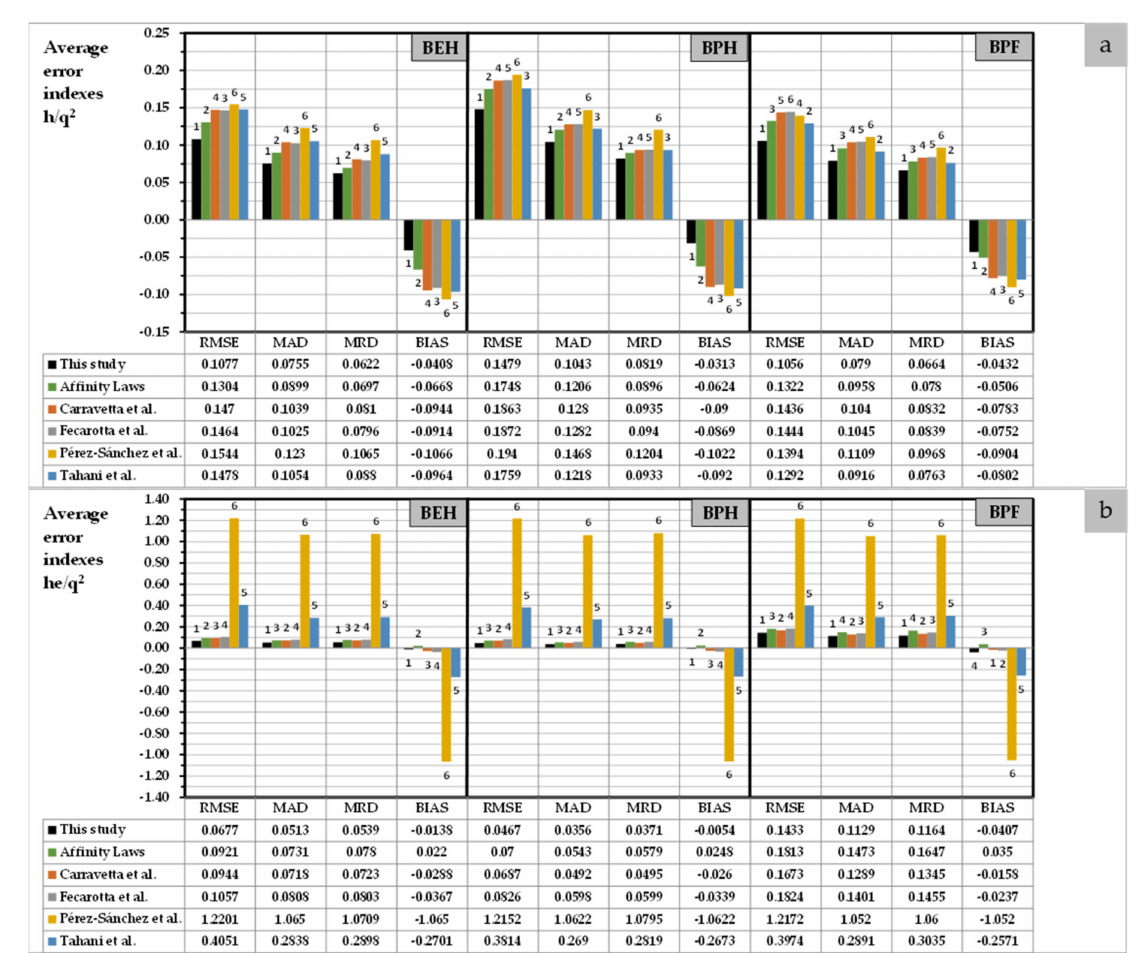
Figure 4. ( a ) Error indexes for the different methods applied to h/q 2 ; ( b ) error indexes for the different methods applied to he/q 2 . If h/q 2 (Figure 4a) is considered for BEH , the RMSE , MAD and MRS errors